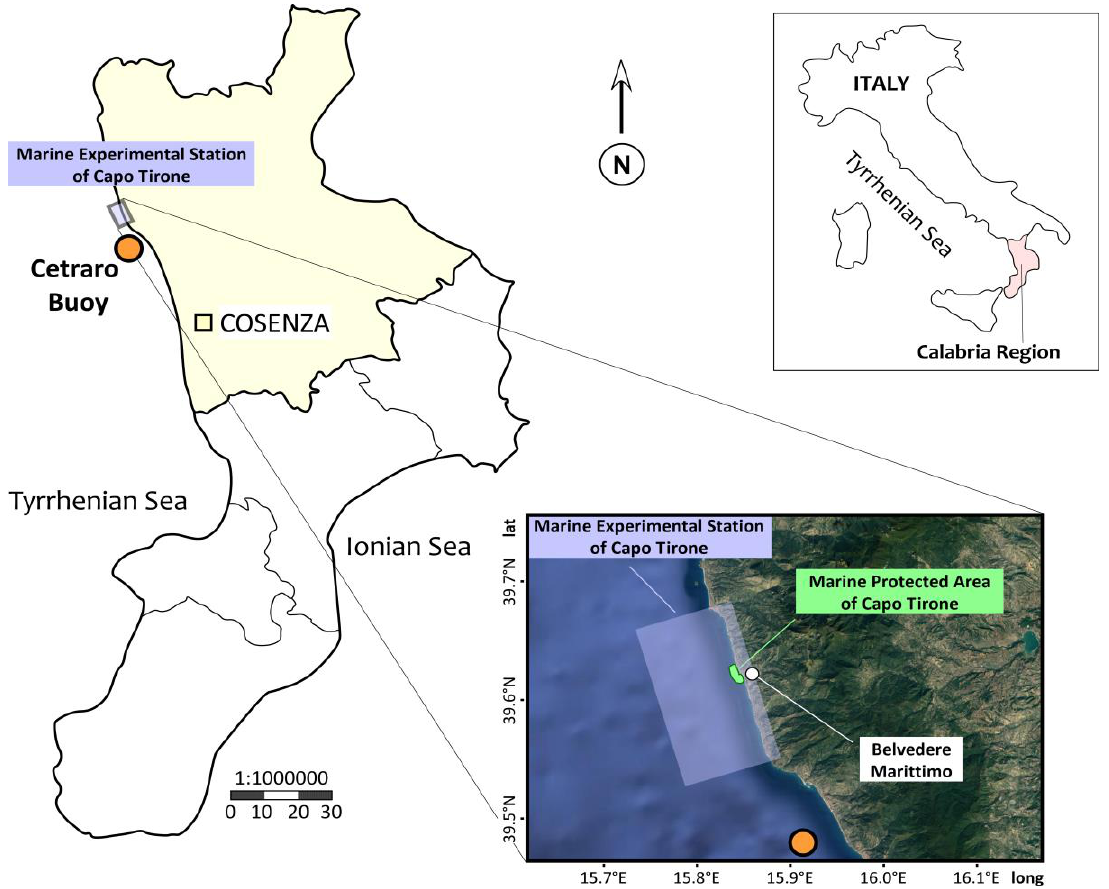
Figure 1. Location of the MESCT (purple area), the SCI_CT (green area), and the Cetraro buoy (orange